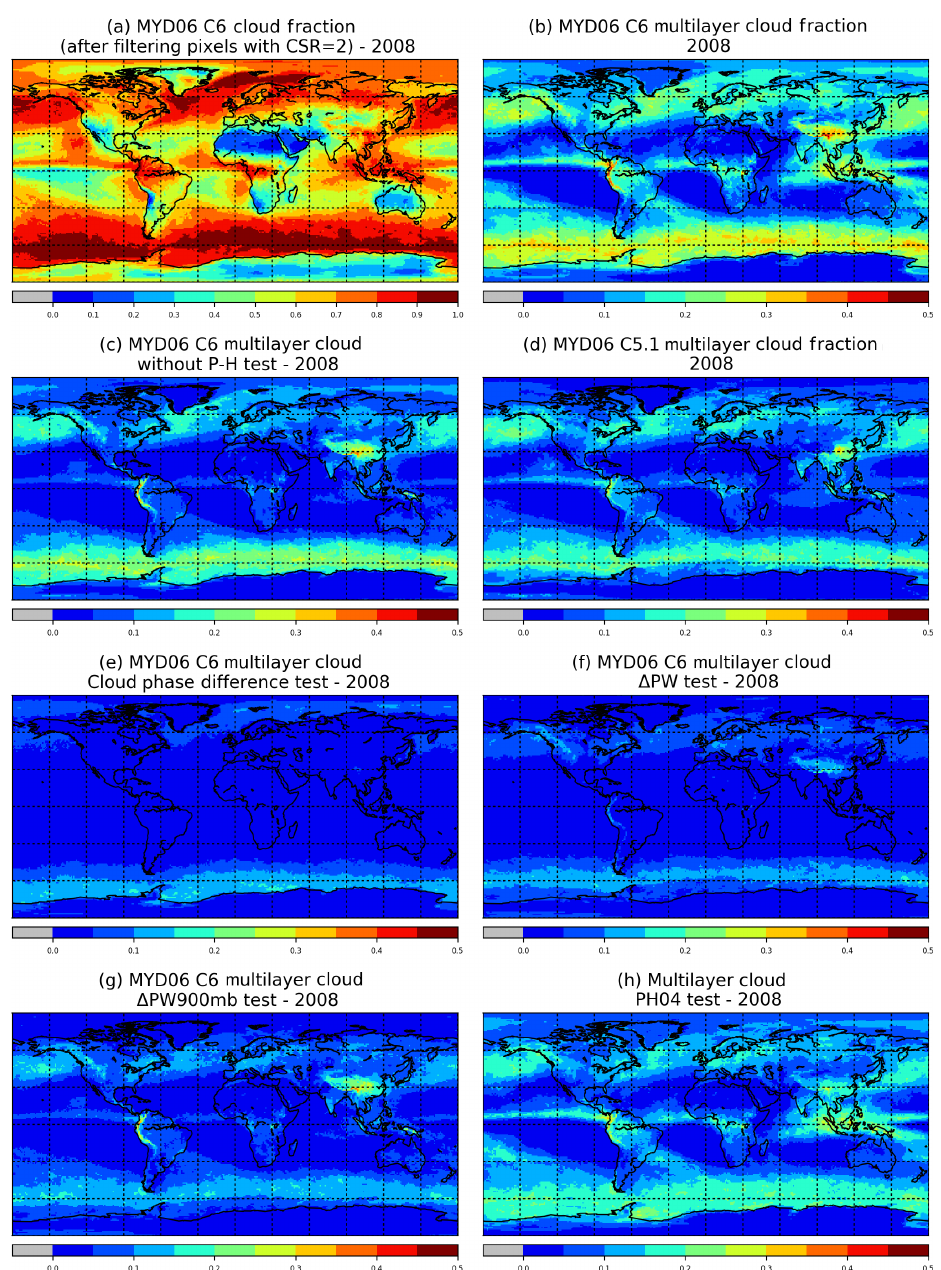
Figure 1. A collection of aggregated (all pixel) Aqua MODIS Level 2 cloud products over the year 2008: (a) cloud fraction, (b) C6.1 multilayer cloud fraction, (c) C6.1 multilayer cloud fraction excluding the Pavolonis and Heidinger (PH04) test, and (d) C5.1 multilayer cloud fraction. Fractions determined from each individual C6.1 multilayer cloud detection test: (e) cloud-phase difference test, (f) (cid:49) PW test (g) (cid:49) PW 900mb test and (h) PH04 test. Note that panel (b) is a weighted combination of panels (e) to (h)